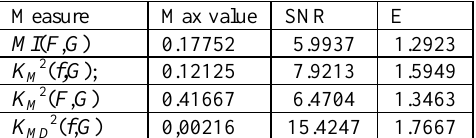
Table 4 Numeric data for TV-IR matching (Example 4).